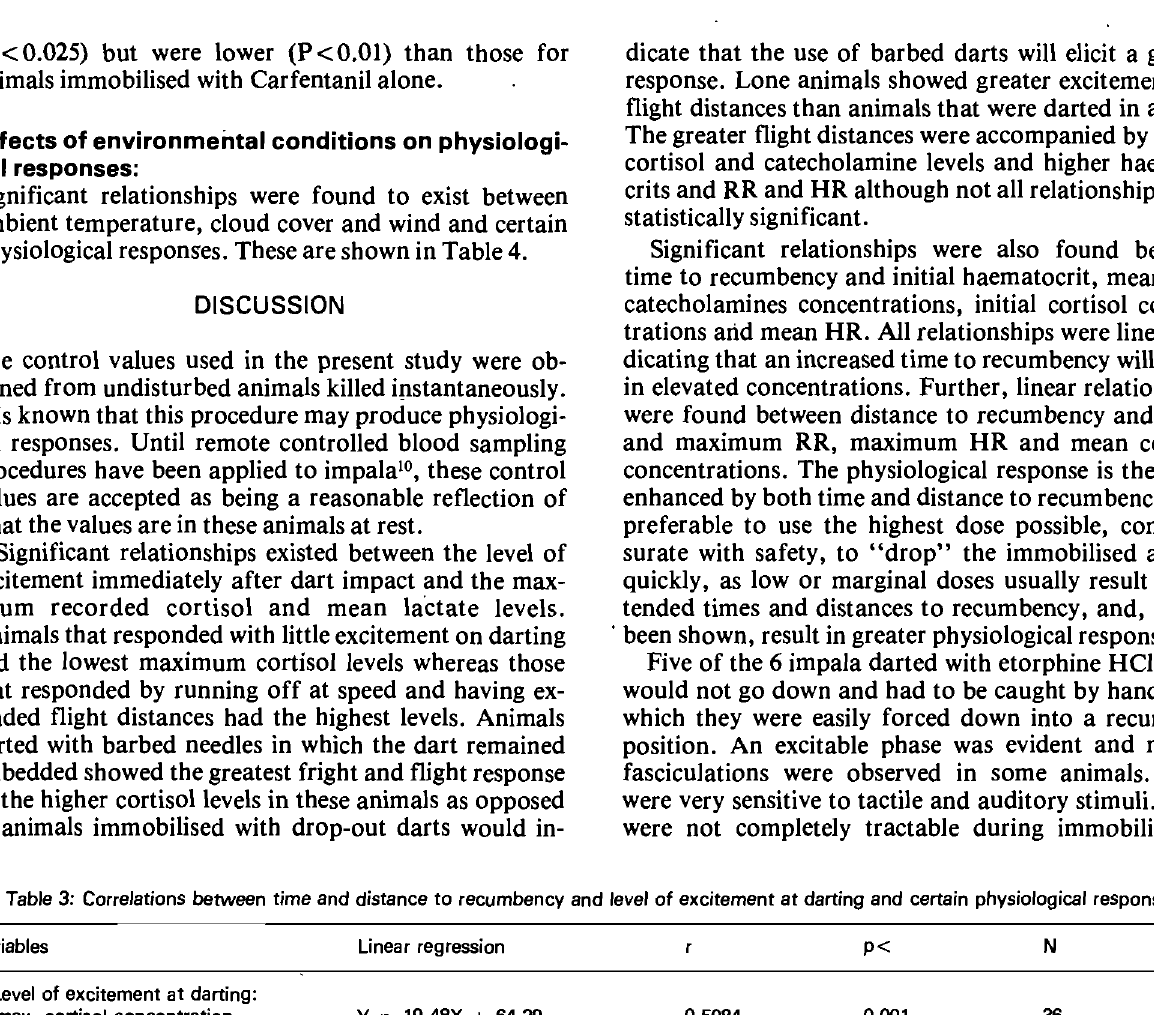
Table 4: Significant correlations between environmental conditions and physiological response. Variable Regression equation Ambient temperature: Vs maximum rectal